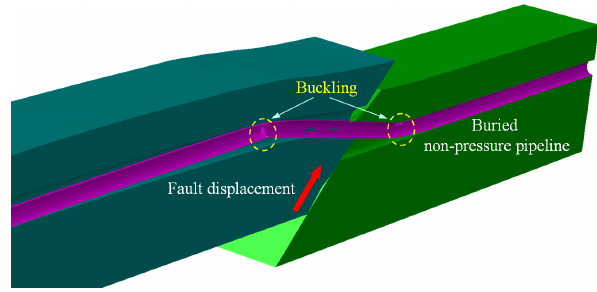
Figure 4. Deformations of the buried non-pressure pipeline and sur- rounding